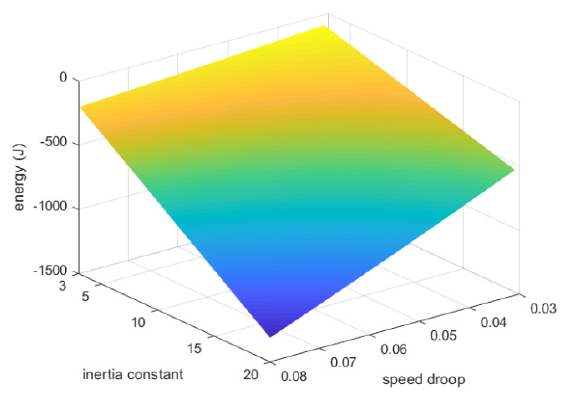
Figure 12. Energy provided by varying H and R at the settling time.